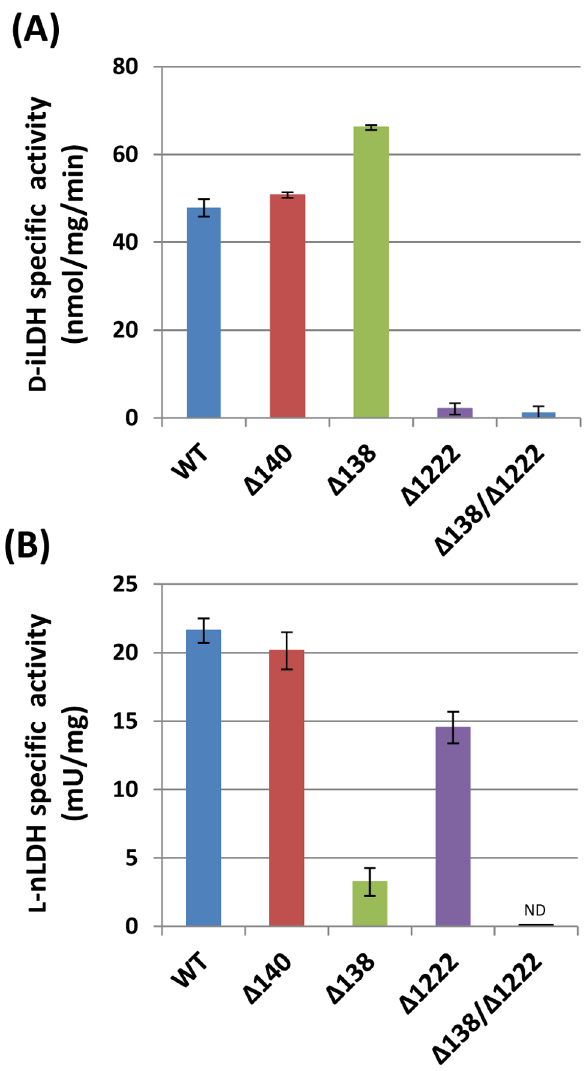
Figure 5. NAD-independent D-lactate dehydrogenase (D-iLDH) and NAD-dependent L-lactate dehydrogenase (L-nLDH) activ- ities in cell extracts of H.pylori 26695 wild type and isogenic mutants. (A) D-iLDH activity was measured as described above. (B) L- nLDH activity was measured by monitoring the reduction of NAD to NADH, arising from the conversion of L-lactate to pyruvate, which was spectrophotometrically detected at 450 nm, and was calibrated based on enclosed NADH standards. All the data represent the means 6 SD of three independent experiments, and one unit of the activity is defined as the amount of enzyme that catalyzes the conversion of lactate into pyruvate to generate 1.0 m mole of NADH per minute at 37 u C.